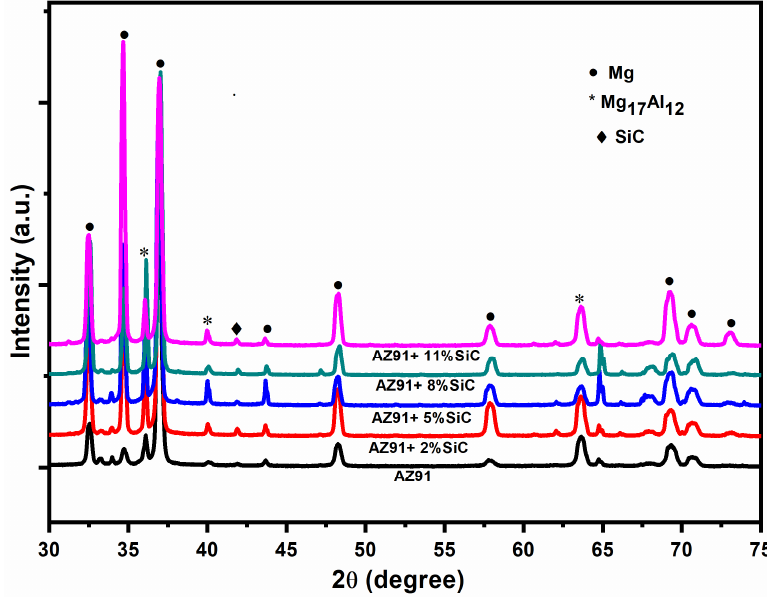
Figure 3. X-ray di ff raction pattern of magnesium alloy and its composites containing di ff erent amounts Figure 3. X-ray diffraction pattern of magnesium alloy and its composites containing different amounts (wt.%) of SiC (2%, 3%, 8% and 11%). (wt.%) of SiC (2%, 3%, 8% and